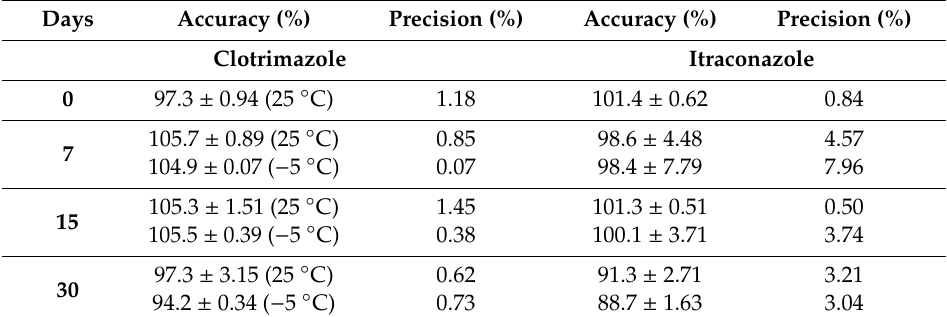
Table 4. Data related to the stability of the assay of the developed HPLC method. N = 2 for each day and condition.